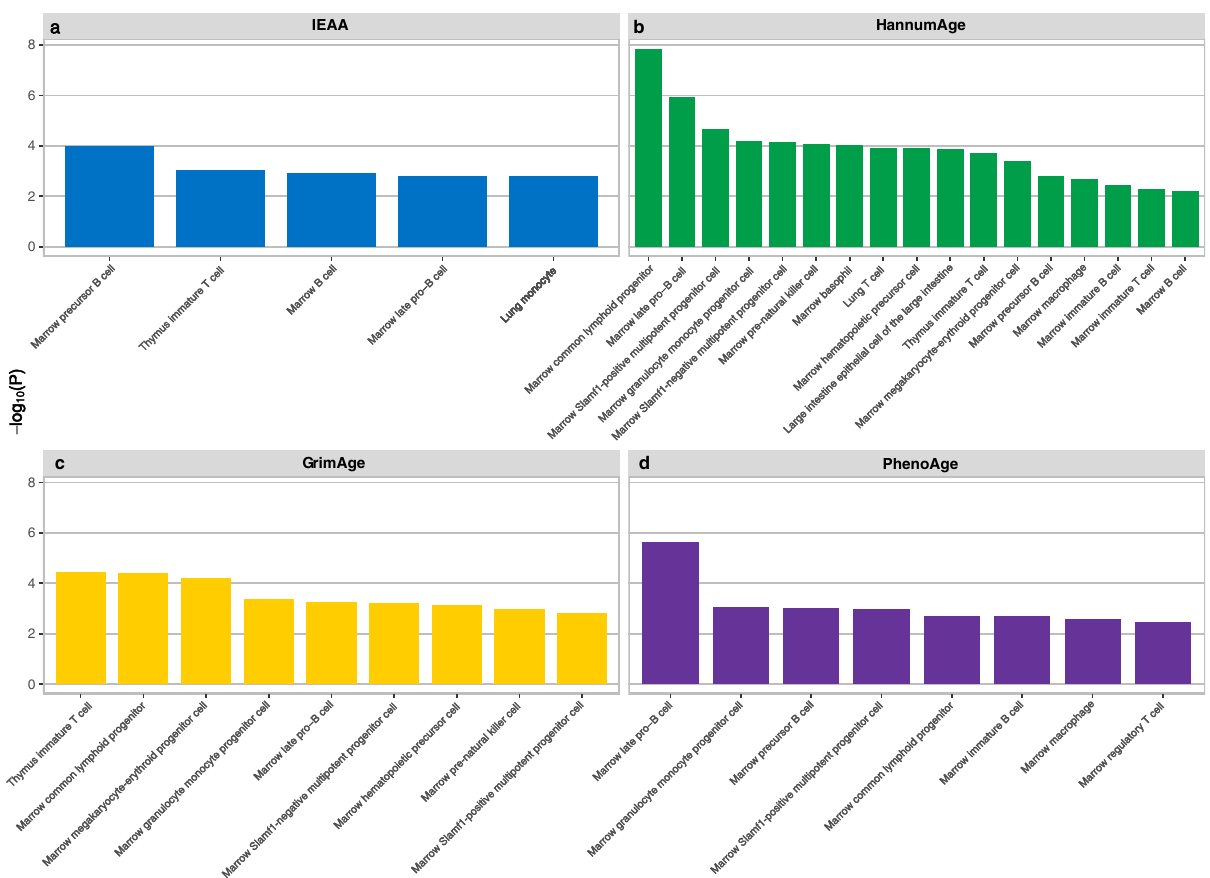
Fig. 4 | CELLECT-MAGMA cellular associations with EAA. a – d Results from CELLECT-MAGMA cell-type enrichment analysis of four EAA traits signi fi cant at a FDR of 0.05. Bars represent negative, log-transformed, unadjusted P values. The scRNA-seq data used in this analysis comes from the Tabula Muris database and encompasses115celltypesfrom20 Musmusculus tissues.Thefullresultsofthecell- type enrichment analyses, including CELLECT-LDSC results and cellular